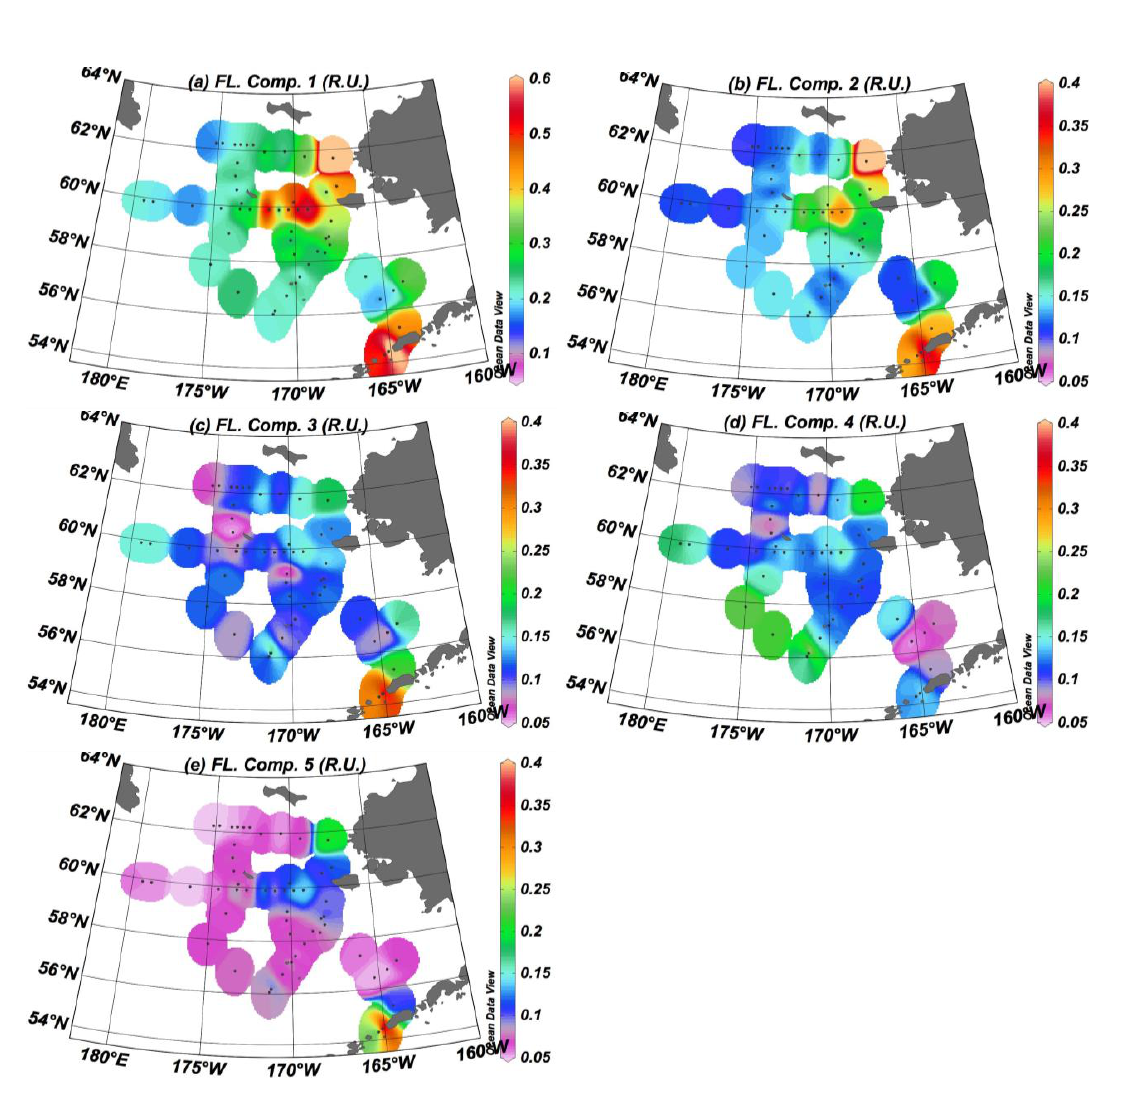
Figure 9. Spatial distributions of (a–e) fluorescence components C1–C5, of surface